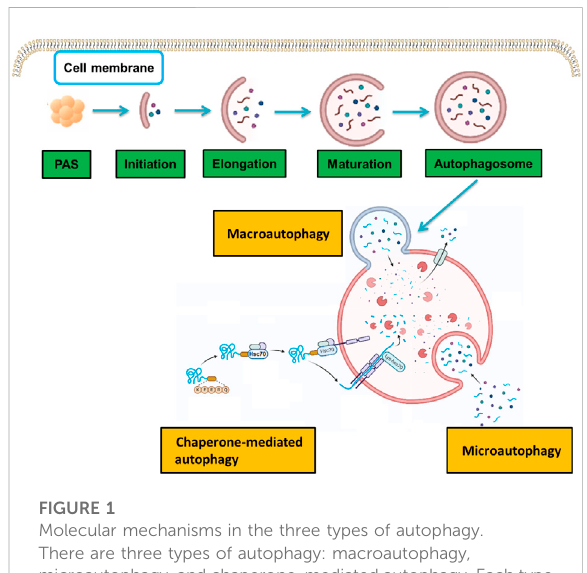
FIGURE 1 Molecular mechanisms in the three types of autophagy. There are three types of autophagy: macroautophagy, microautophagy, and chaperone-mediated autophagy. Each type involves a speci fi c molecular mechanism of delivery to